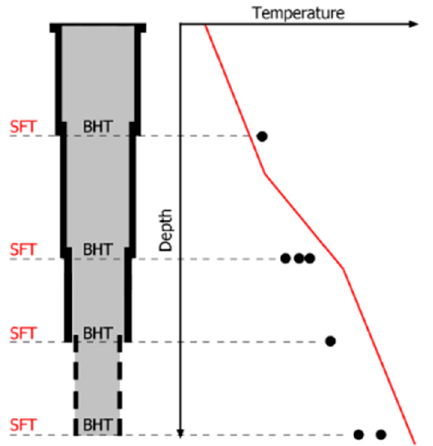
Figure 1. Schematic of exemplary bottom-hole temperature (BHT) measurements in a borehole. The BHTs (black dots) can be present single or, if several were measured at one depth, as a series of measurements. Due to the thermal influence of the previous drilling, BHTs deviate from the static formation temperature (SFT), which can be derived by the geothermal gradient (red line).